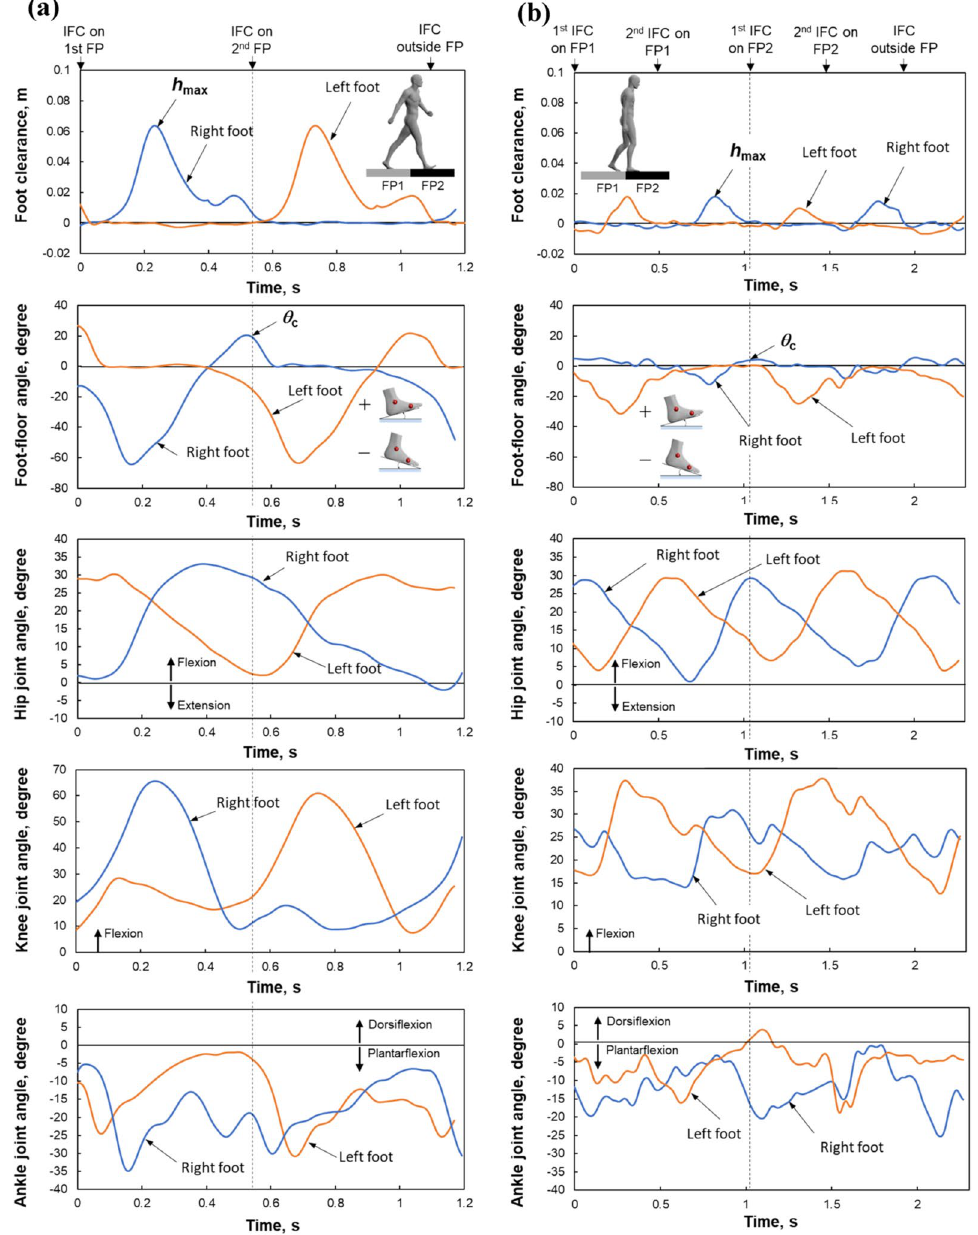
Figure 4. Example of the temporal change for a single subject in the foot clearance, foot–floor angle, hip joint angle, knee joint angle, and ankle joint angle during the normal ( a ) and shuffling gaits ( b ) under the low friction condition. h max is the maximum value of the foot clearance before the foot contact on the second force plate, corresponding to the local maxima of the toe clearance. θ c is the foot–floor angle at initial foot contact (IFC) on the second force plate. IFC timing for each step except the first step on the first and second force plates (FPs) were indicated with